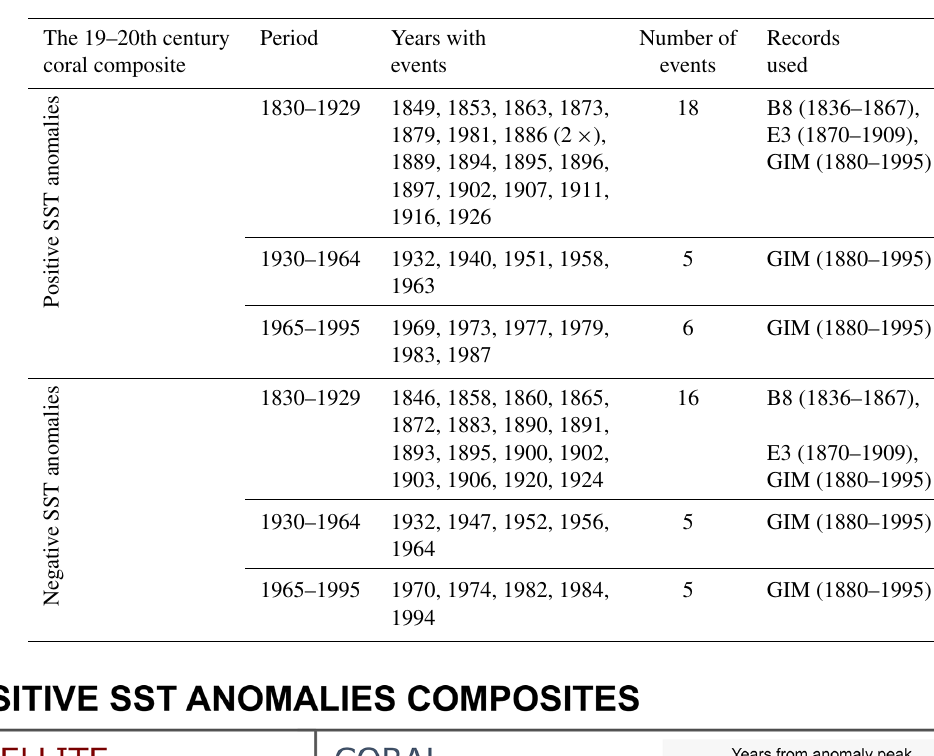
Table 5. The 19–20th century (divided into three periods) positive (El Niño events) and negative (La Niña and non-La Niña events) SST anomaly events picked for generating coral composite records shown in Fig. 9.